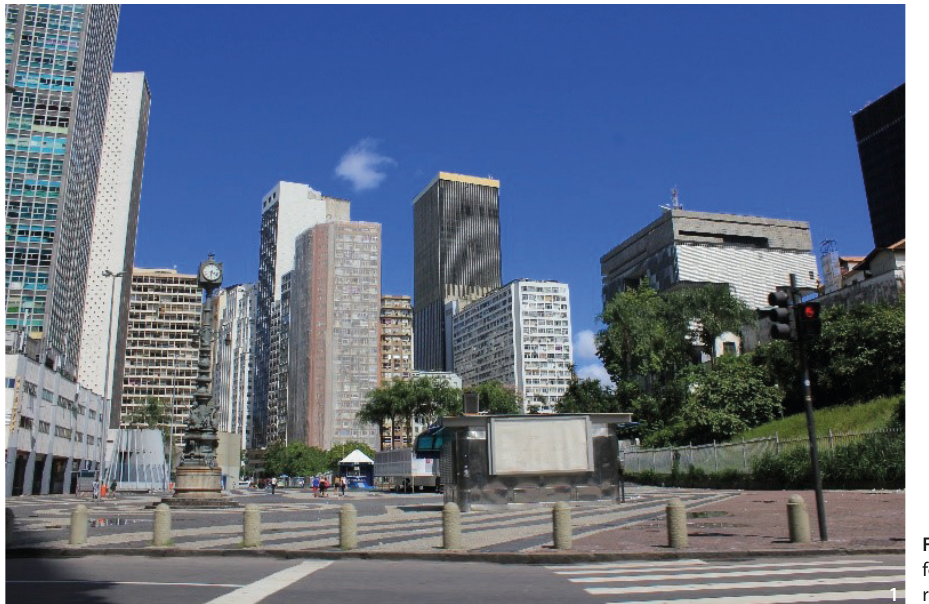
Figure 1 Central business districts for competitive cities (Rio de Janei- ro city centre) (Source: the author).